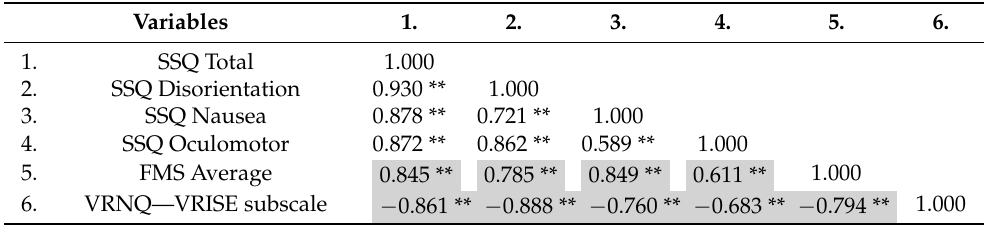
Table 9. Correlation matrix for HA_RFH condition—Spearman ( ρ ) correlation coefficients for com- bined VRISE measures ( n =